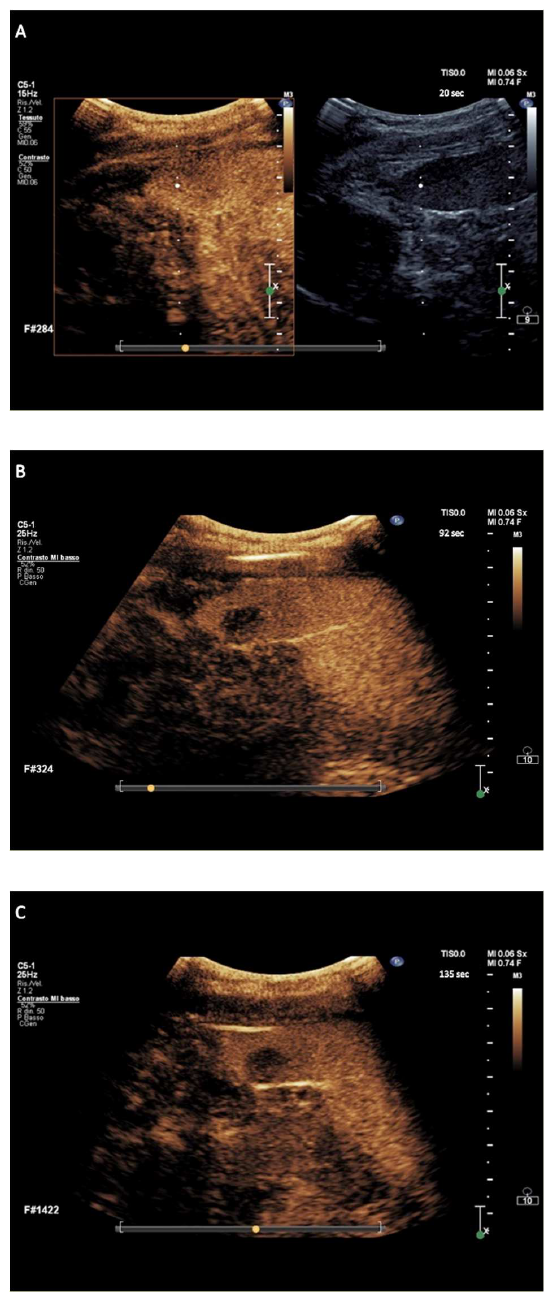
Figure 3. Major features of CEUS according to the exploratory diagnostic criteria. ( A – C ) showing classic Hodgkin lymphoma nodule with discretely marked wash-out, at 92 s from contrast agent